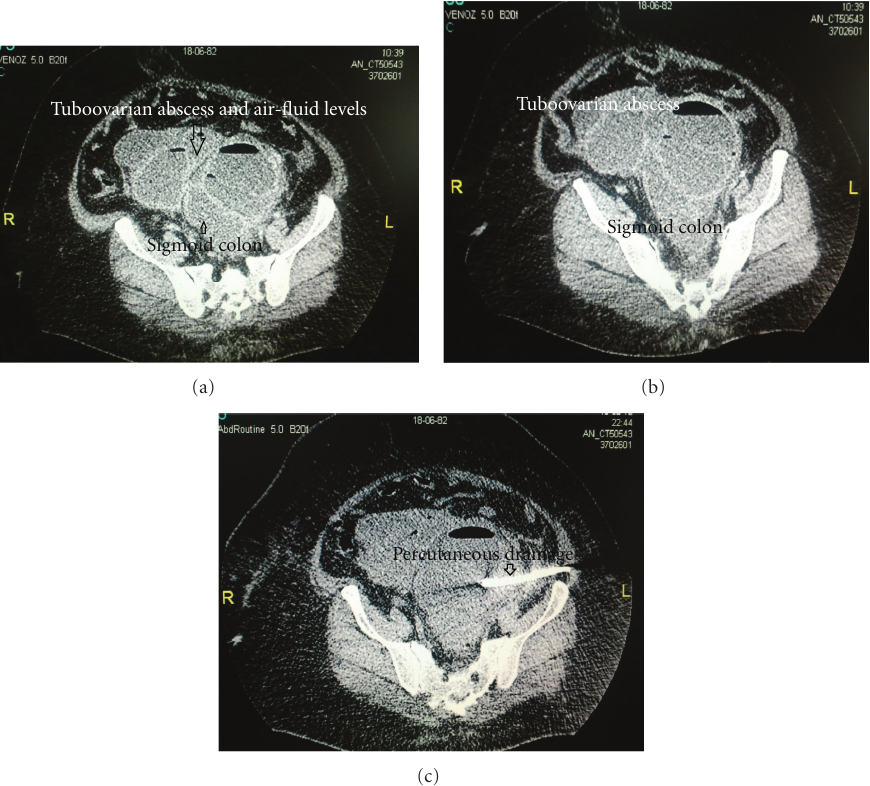
Figure 1: (a) The sigmoid colon was lying between two tuboovarian masses, and its borders could not be distinguished from the ovaries. (b) The sigmoid colon was lying between two tuboovarian masses. (c) Percutaneous drainage.